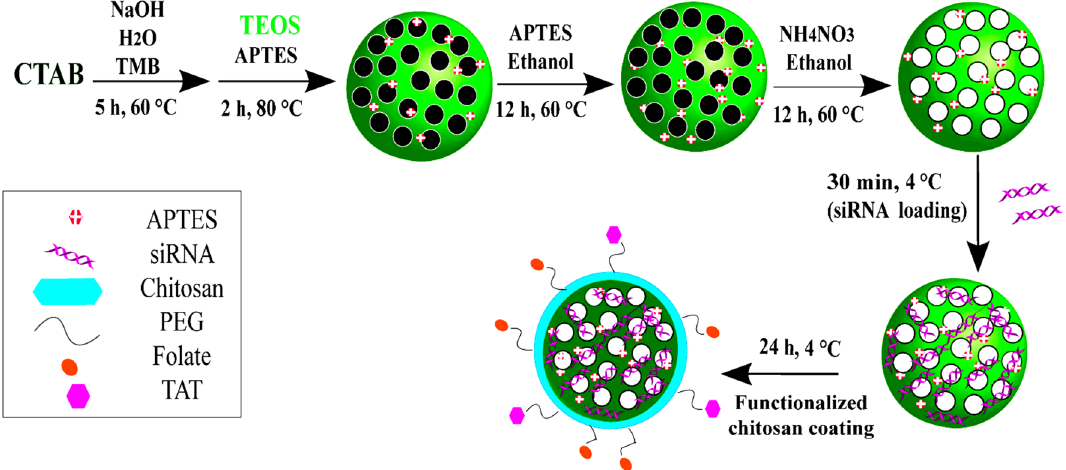
Figure 1. Schematic illustration of synthesis steps and mesoporous silica nanoparticles (MSNs) functionalization to obtain NH 2 -MSN, NH 2 -MSN-siRNA, and NH 2 -MSN-siRNA-chitosan functionalized with PEG-folate and PEG-TAT. APTES 3-Amino propyltriethoxysilane, CTAB cetyltrimethylammonium bromide, PEG polyethylene glycol, TAT trans-activator of transcription, TMB 1,3,5-triisopropylbenzene, TEOS tetraethyl